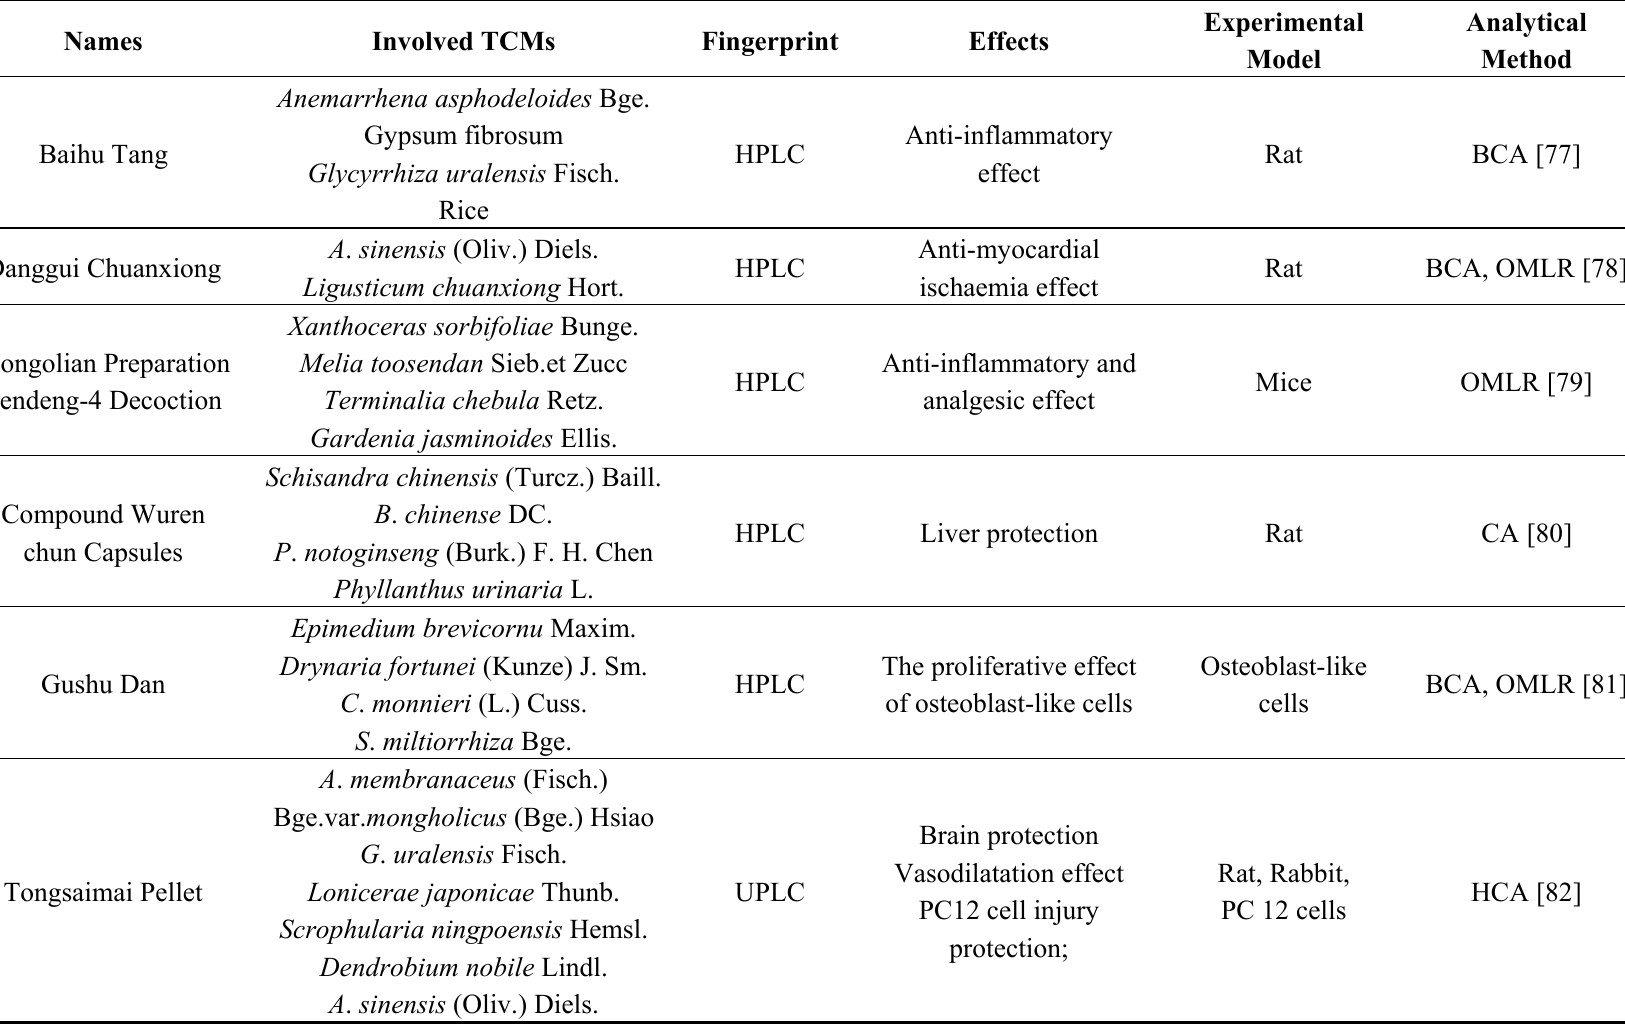
Table 2. Summary of Chinese herbal formula spectrum-effect relationships (for abbreviations refer to the footnote in Table